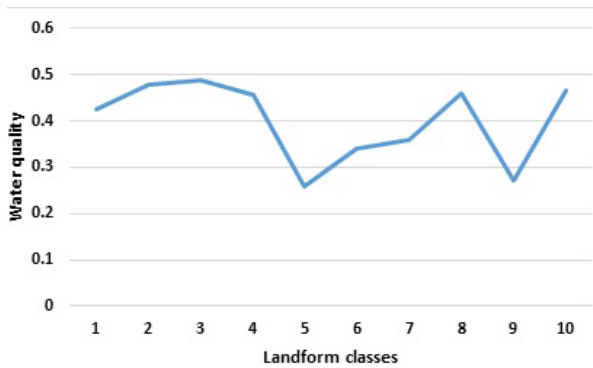
Figure 11. Relationship between drinking water quality based on content of inorganic components and landform